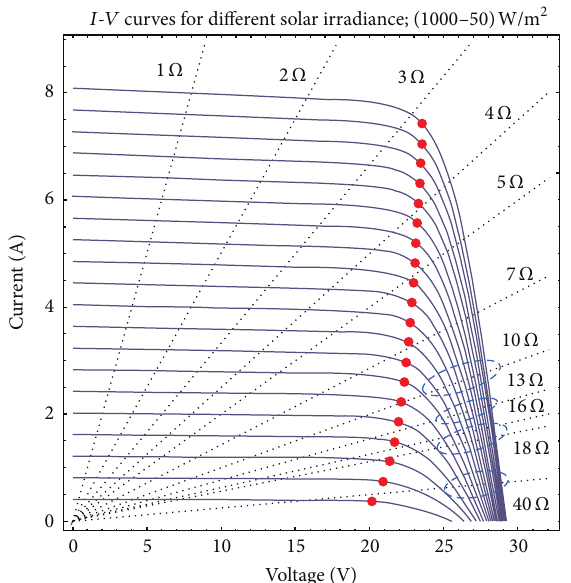
Figure 3: 𝐼 - 𝑉 curves of a PV panel at constant temperature (25 ∘ C) and electric load lines. Red points indicate maximum power and blue dashed circles indicate overlap regions where module is in saturation conditions.